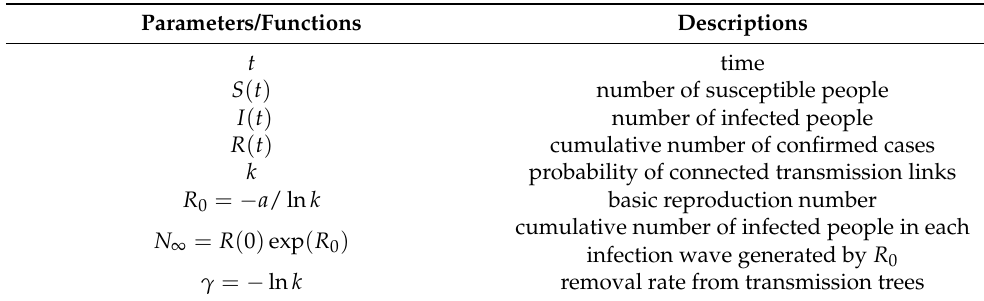
Table 2. The parameters and functions for the broken-link model. For the basic reproduction number R 0 , the constant parameter a is determined from the fit to the actual data. The analytic expressions of R 0 , N ∞ and γ are obtained by solving Equations (3) and